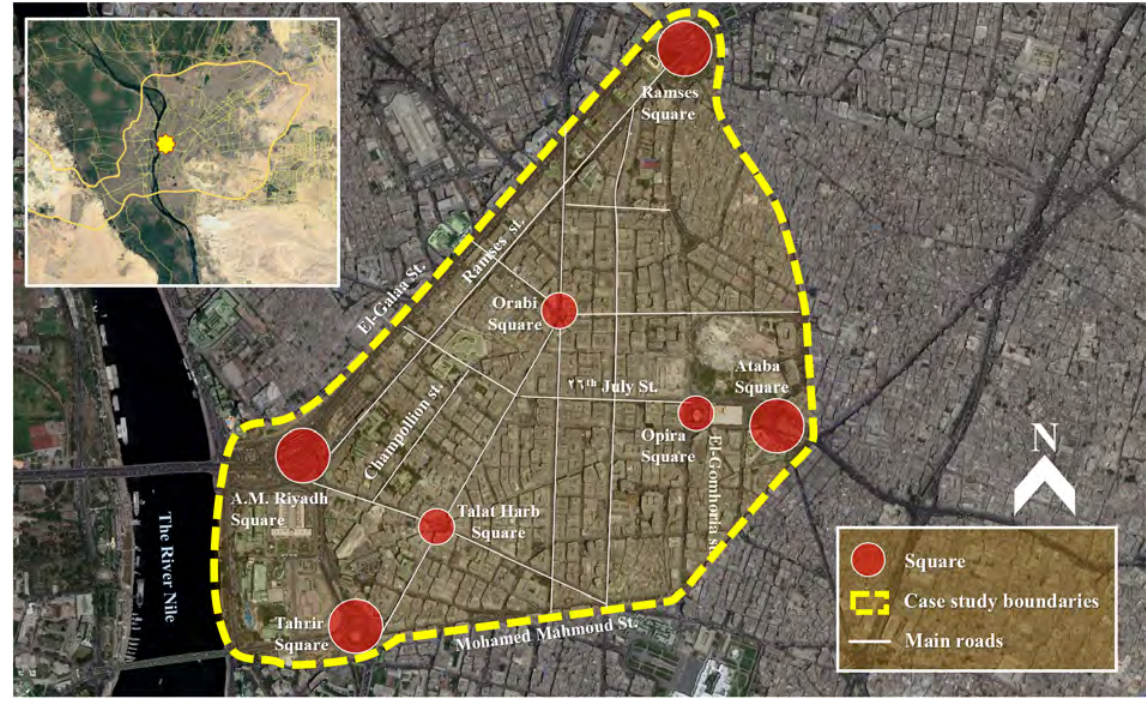
Figure 14. Case study boundaries. (Researcher,